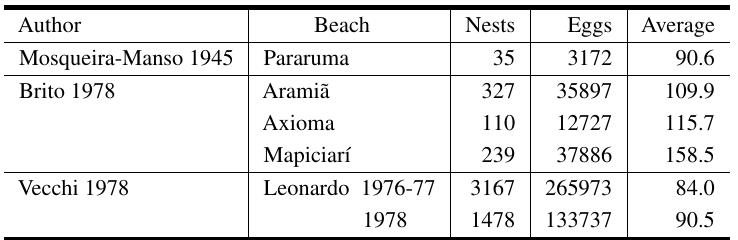
Podocnemis expansa , data on clutch size.